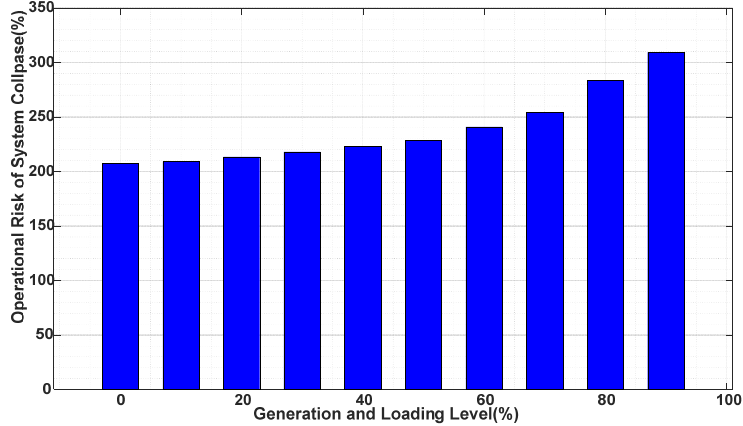
Figure 6. Operational risk of system collapse as a function of GLL.